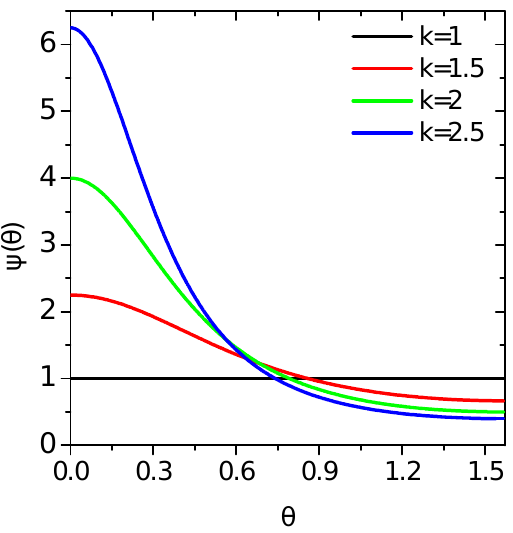
Figure 1. Probability density function (PDF) for the zenith angle for different deformations ( k ) for the carbon nanotubes